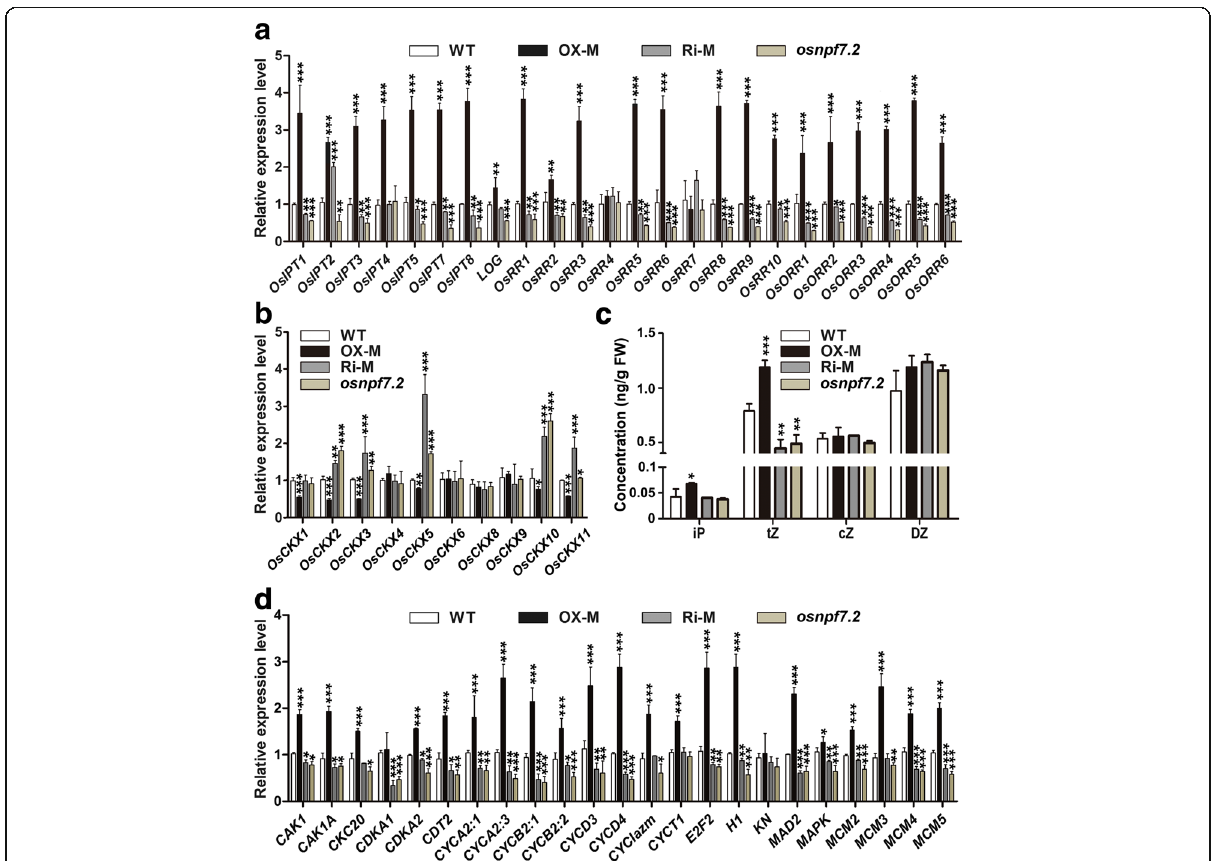
Fig. 5 Altered expression of OsNPF7.2 regulated CKs concentration and cell cycle. a Expression level of rice genes involved in cytokinin synthesis and response in tiller buds of seedlings at 34 DAG among WT, OX-M, Ri-M and osnpf7.2 . b Expression of 10 CKXs at 34 DAG among WT, OX-M, Ri- M and osnpf7.2 . c CK free base concentration in seedling tiller basal portion at 34 DAG among WT, OX-M, Ri-M and osnpf7.2 . c Comparison of genes involved in cell cycle in tiller buds of seedlings at 34 DAG among different transgenic lines. OX-M and Ri-M in ( a )-( b ) and ( d ) was identical to that in fig. 4d. OX-M and Ri-M in ( c ) indicated tiller basal portion (about 0.5 cm) mixed from 30 seedlings of each OX lines and Ri lines, respectively. Date are shown as mean±SD from three replicates; “ * ” , “ ** ” and “ *** ” indicated significant differences at P <0.05, P <0.01 and P <0.001,